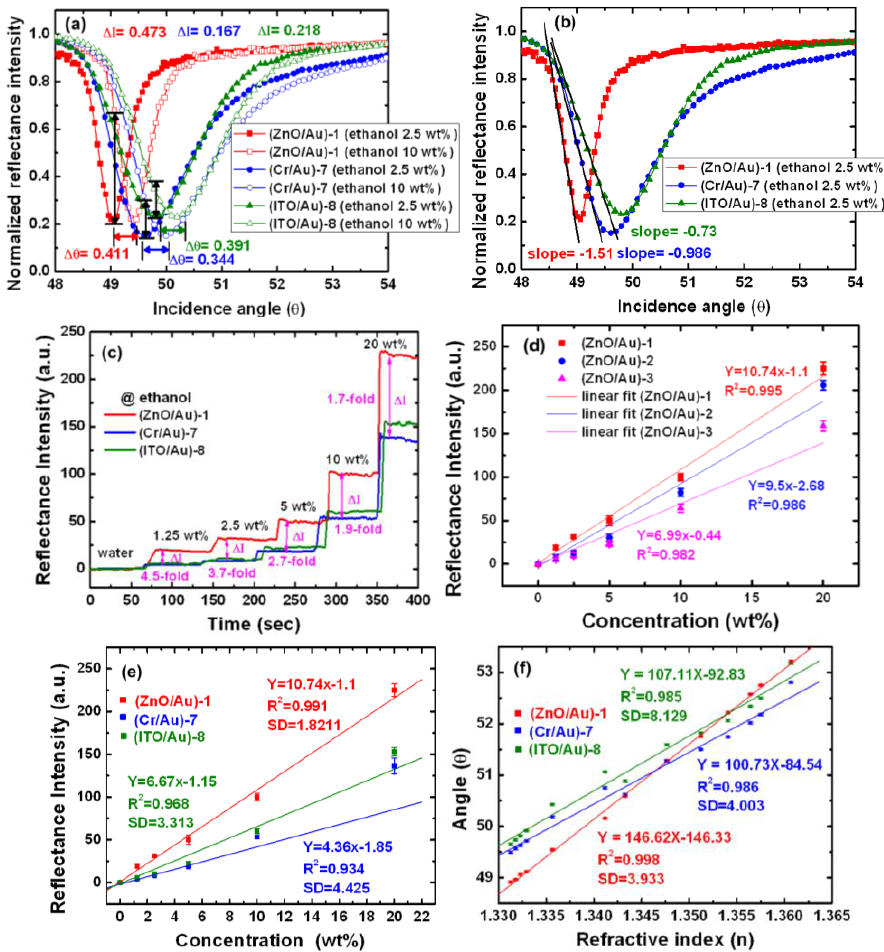
Figure 5. Comparison of SPR reflectivity curves obtained at different ethanol concentrations. ( a ) Reflective intensity and SPR angle shift. ( b ) Analysis of the change in slope of the SPR reflectivity curves. ( c ) Real-time monitoring of the response of (ZnO/Au)-1, (Cr/Au)-7, and (ITO/Au)-8 devices in water (0 wt%) and in 1.25, 2.5, 5, 10, and 20 wt% ethanol solutions. ( d ) Intensity interrogation mode measurement results obtained for the (ZnO/Au)-1, (ZnO/Au)-2 and (ZnO/Au)-3 devices in 0–20 wt% ethanol solutions. ( e ) Intensity interrogation mode measurement results obtained for linear regression of the (ZnO/Au)-1, (Cr/Au)-7 and (ITO/Au)-8 devices over dynamic sensing range of 0–20 wt%. ( f ) Angular interrogation mode measurement results obtained for the (ZnO/Au)-1 device in water and ethanol solutions; the angle shifted from 48.914° in water to 53.217° in 95 wt% ethanol. Calibration curves for (ZnO/Au)-1, (Cr/Au)-7, and